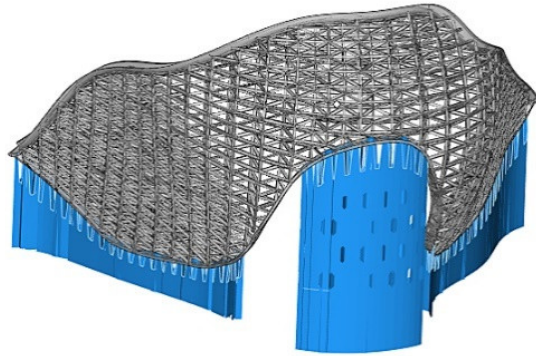
Figure 8. Thyroid cartilage prosthesis with data processing.